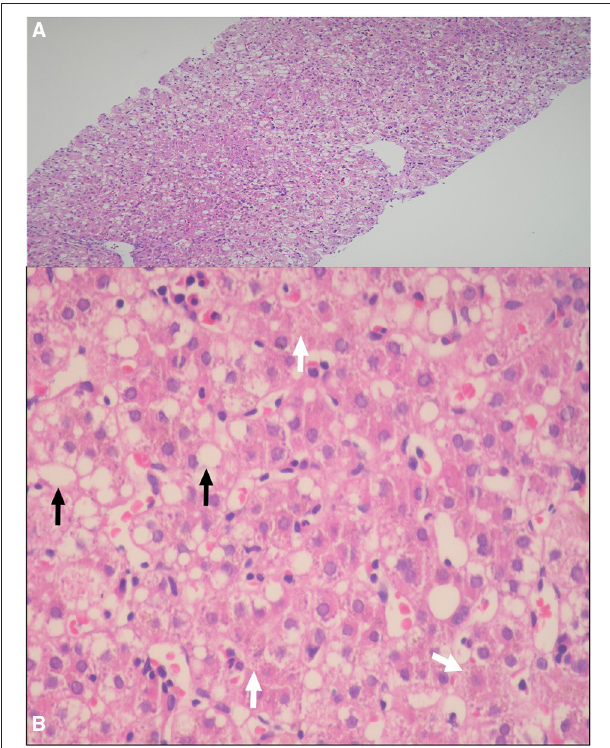
FIGURE 2 | (A,B) Percutaneous liver biopsy demonstrating: (A) Marked micro- and macrosteatosis of hepatocytes [hematoxylin and eosin (HE), original magnification × 4]; (B) Dark pigment granules in hepatocytes (arrows heads), and steatosis of hepatocytes (arrow) (HE 20 ×